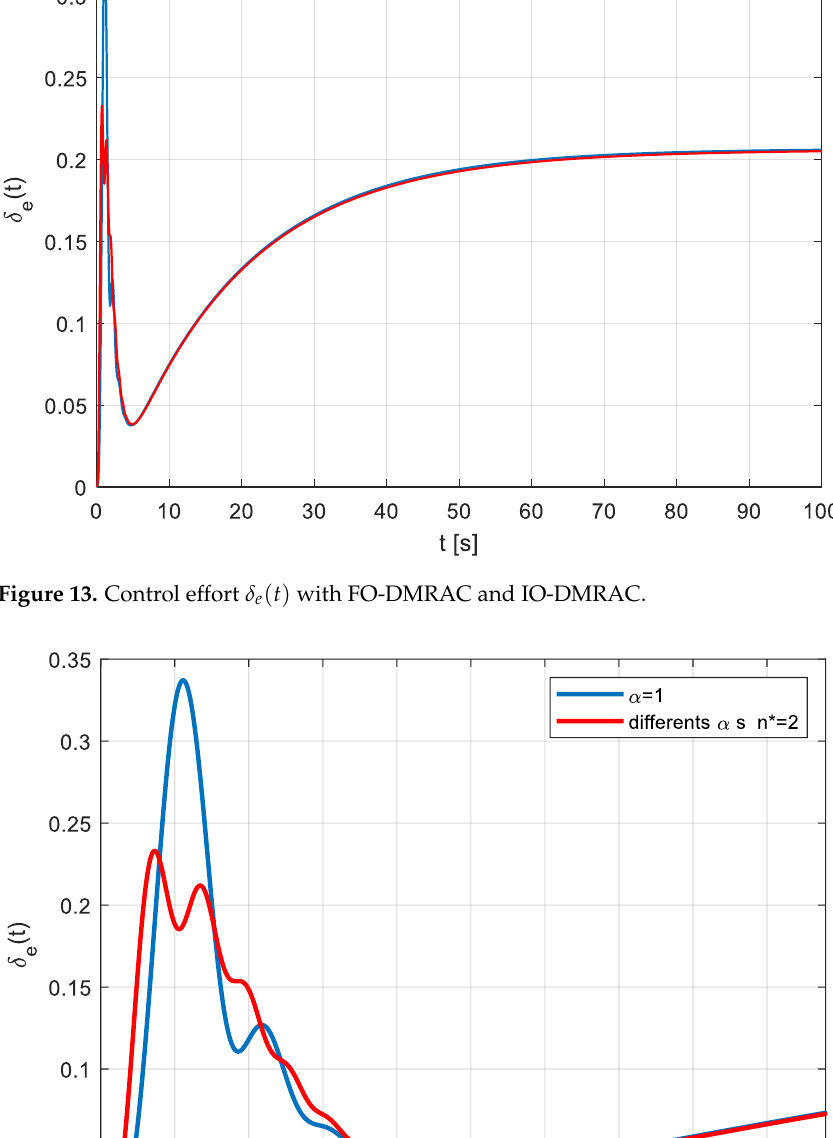
Figure 12. Zoom of the variations of the pitch angle 𝜃(𝑡) shown in Figure 11 by using IO-DMRAC and FO-DMRAC.